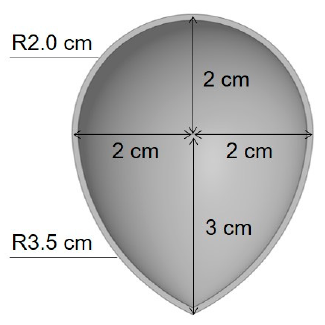
Figure 1. Schematic diagram of oyster shells considered in this study.